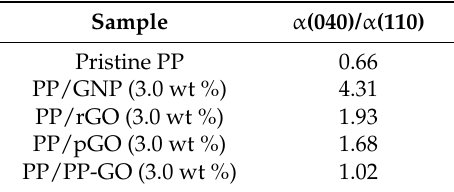
Figure 7. WAXD patterns of ( a ) pristine PP; ( b ) PP/GNP (3.0 wt %); ( c ) PP/rGO (3.0 wt %); ( d ) PP/pGO (3.0 wt %); and ( e ) PP/PP-GO (3.0 wt %) nanocomposites. Table 1. Intensity ratio of α (040)/ α (110) for PP nanocomposites. Sample